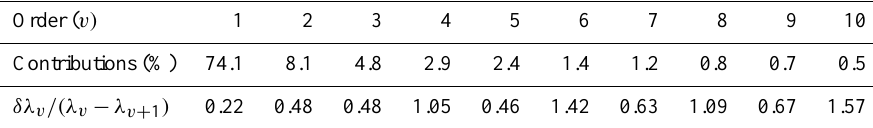
Table 1. Contributions of first ten order EOFs and ratios δλ v /(λ v − λ v + 1 ) .